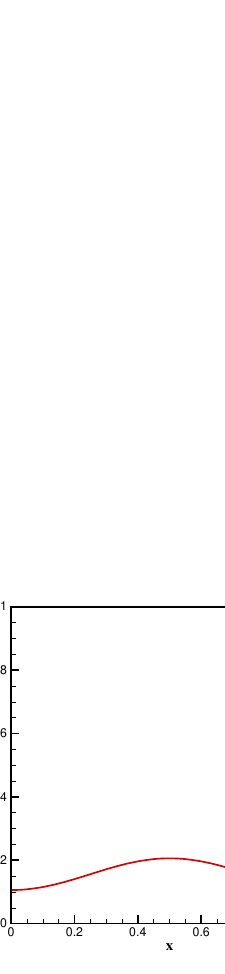
Figure 6. Bubble growth from the vapor film at Gr = 2482.58, Ja = 0.064, and Pr = 0.094. The phase boundary is shown at different times. From left to right: t ∗ = 0, t ∗ = 9.8, and t ∗ = 14.96.